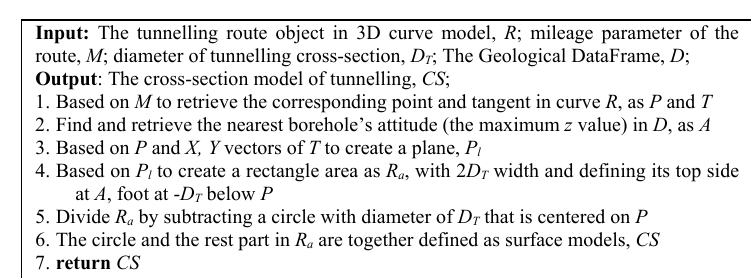
Algorithm 2 . Parametric modelling for the target